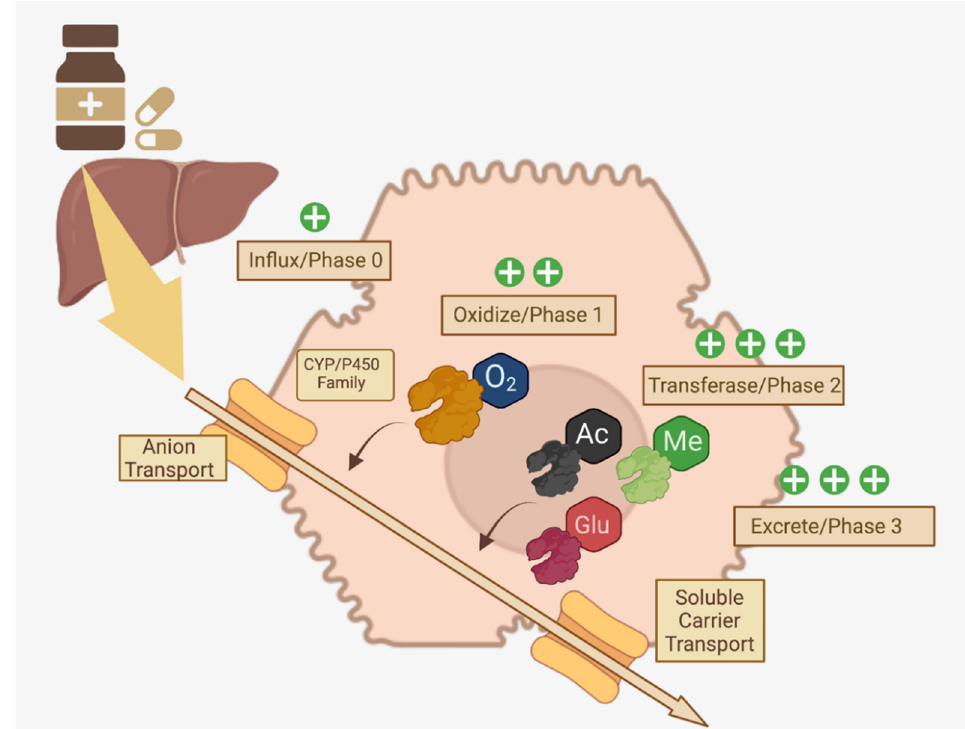
Figure 2. Multi-Phase Drug Metabolism in Hepatocytes . Distinct phases of drug metabolism that increase polarity through enzymes that modify xenobiotics via addition of functional groups are crucial for excretion of ingested medications [25,28,29,32]. Created in BioRender.com.